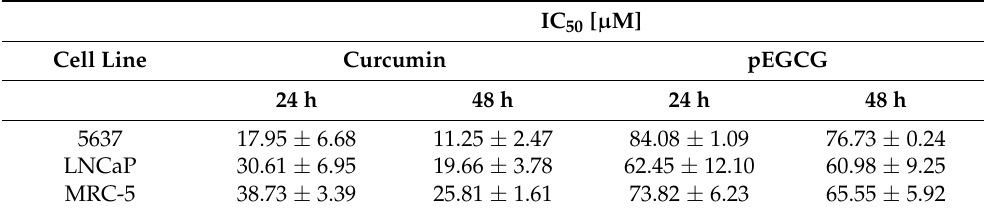
Table 5. The IC 50 values of curcumin, pEGCG, and their combinations dissolved in DMSO. Data are expressed as the mean ± SD from at least three independent experiments; only pEGCG for 5637 cell line presents mean from two independent